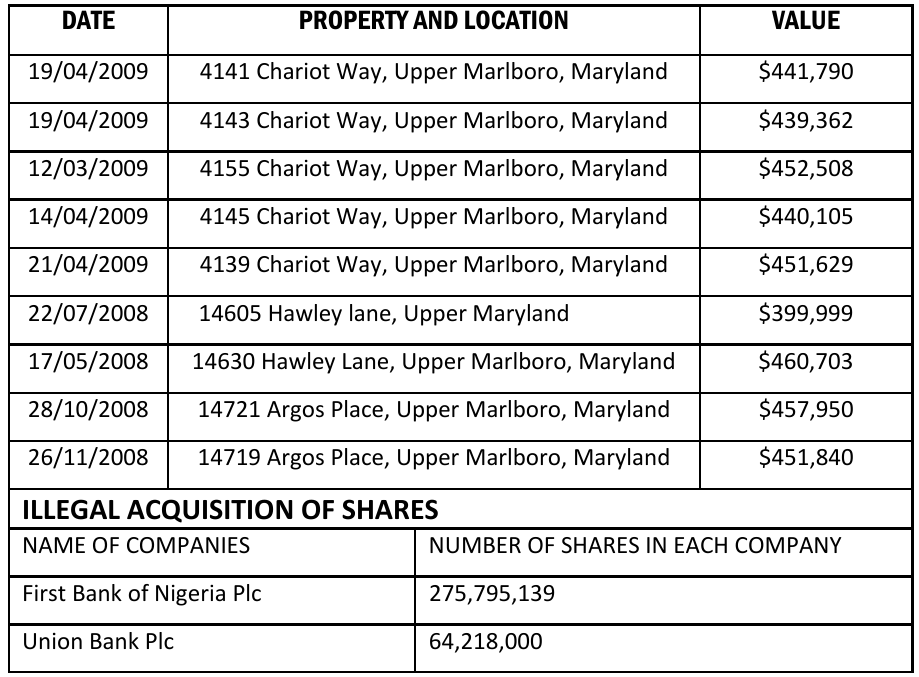
Table 2: Illegal Acquisition of